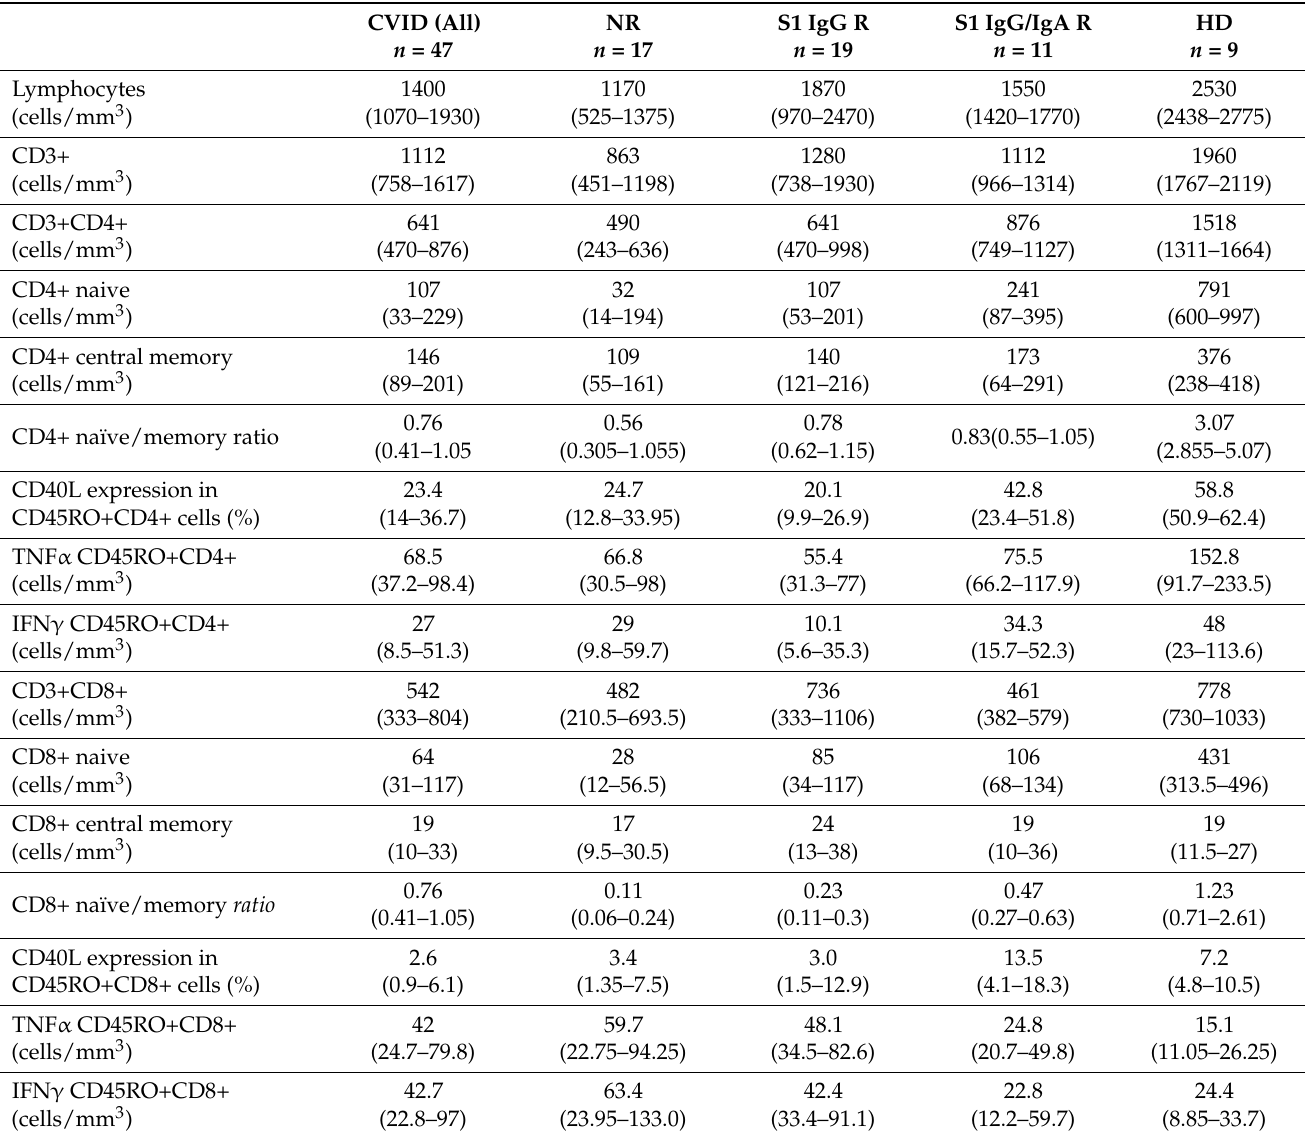
Table 2. Count of peripheral lymphocytes, CD3+, CD4+ and CD8+ subsets, CD40L in CD45+CD4+RO+ (expressed as percentage), and count of CD45+CD4+RO+ and